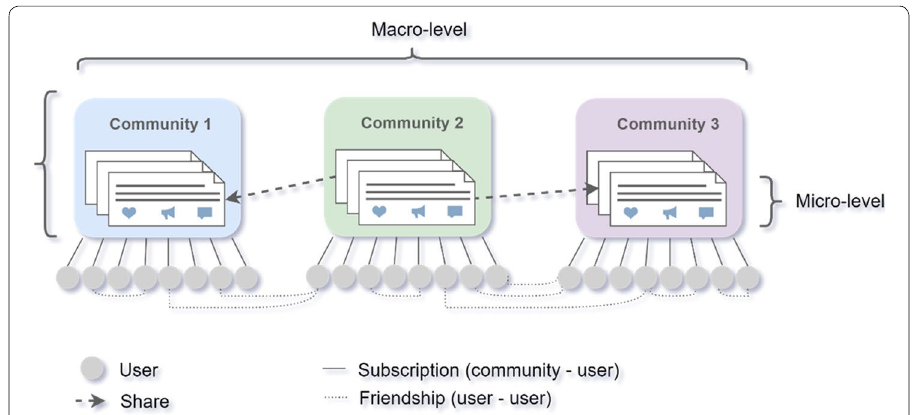
Fig. 1 Online social networks—micro, meso and macro